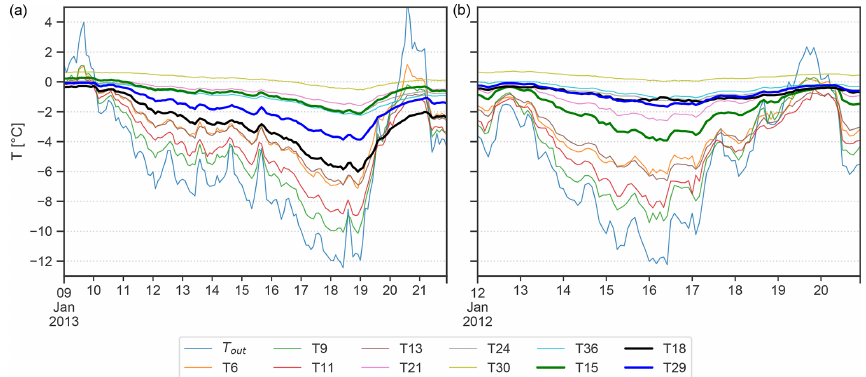
Figure 8. Temperature conditions during cold-air events in January 2013 (a) , showing unrestricted ventilation conditions, and in Jan- uary 2012 (b) with restricted ventilation due to the closed door at the lower entrance shaft. Bold lines highlight the loggers at which a drastic change in behaviour between the two scenarios was observed (T15, T18 and T29). Table 2. Properties of the linear regression models for ablation (abl) and annual mass balance (mb) calculated from degree-day sums at values resulting from the model and the 95% bootstrapping confidence intervals (in brackets) are shown. The RMSE is calculated for the out-of-sample prediction for the years 2008 and 2018–2020, verified with measurements at stakes B (2008) and P4